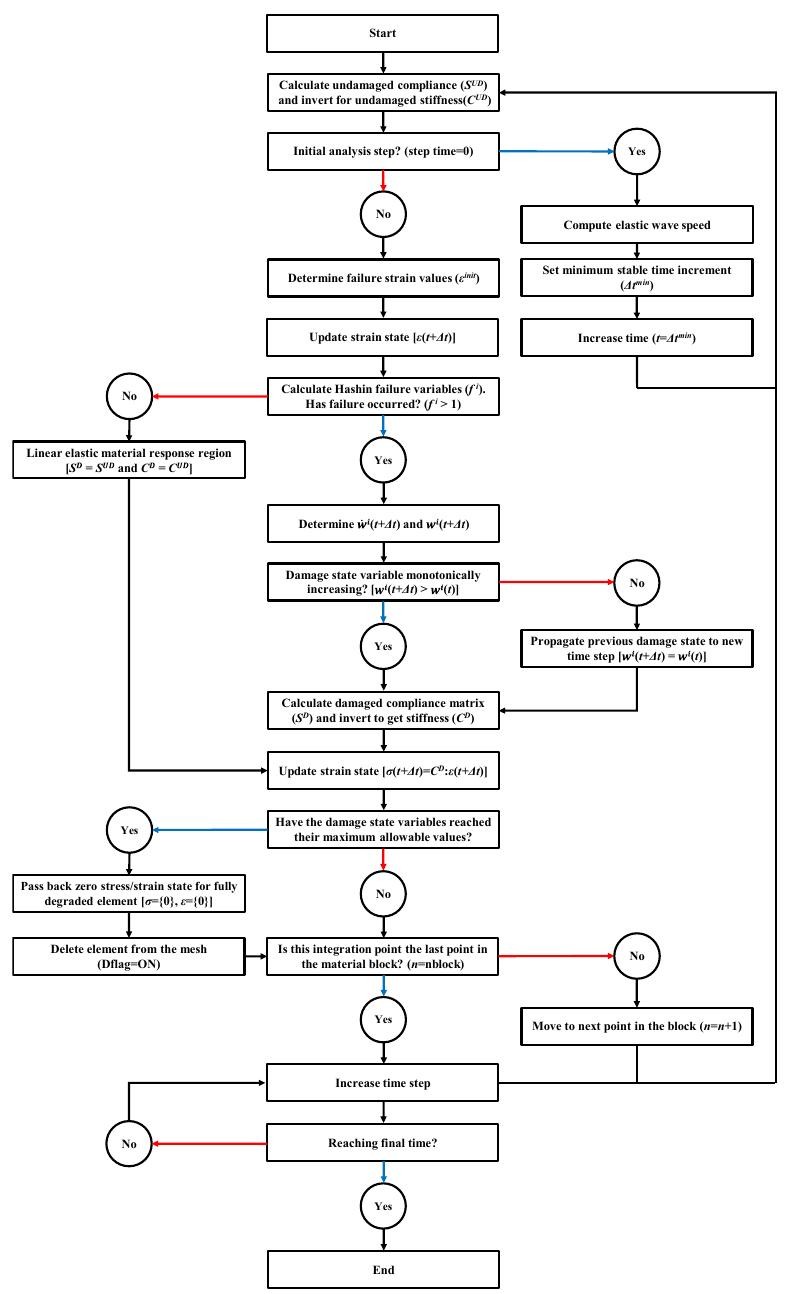
Figure 5. VUMAT flowchart for damage progression of composite in ABAQUS.